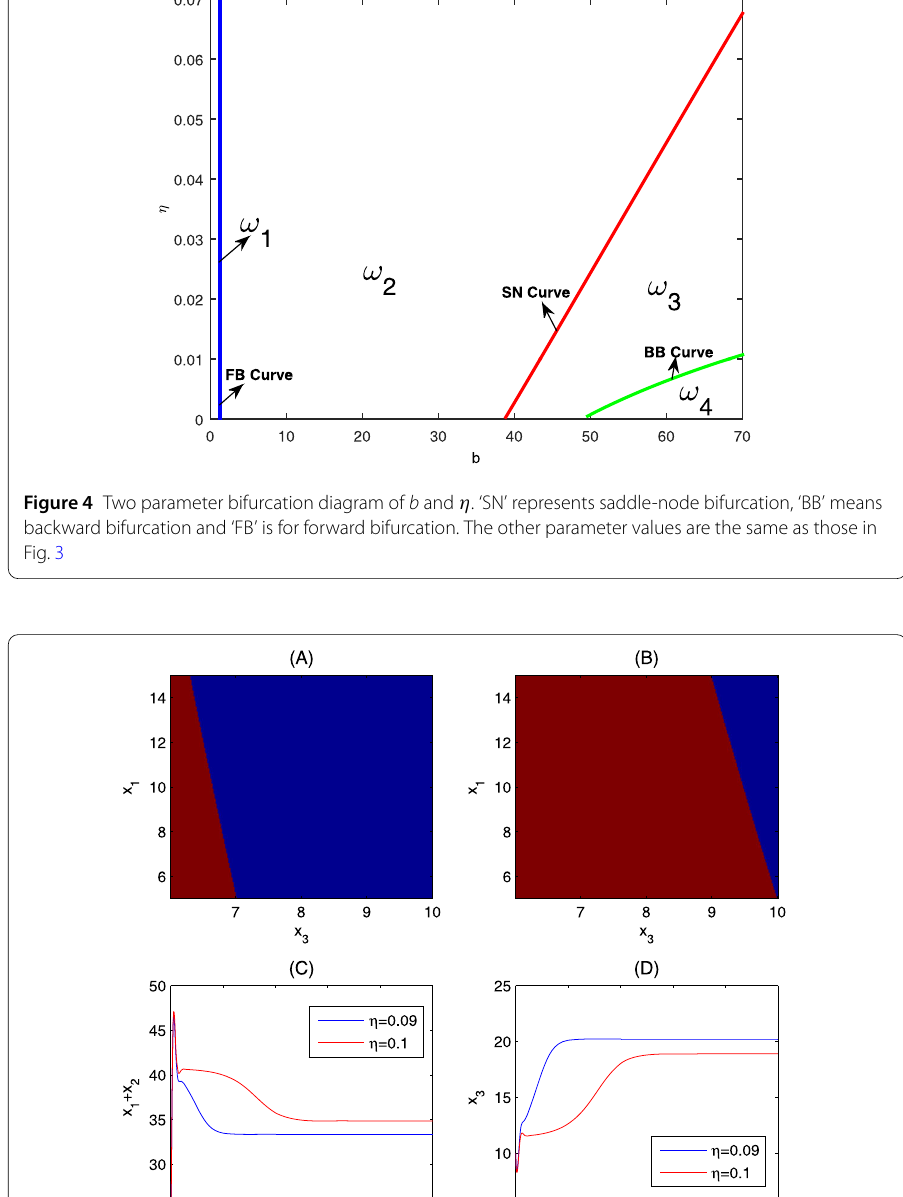
at the green region. As we can see, if we fix the initial condition of x 3 between 6.5 and 7